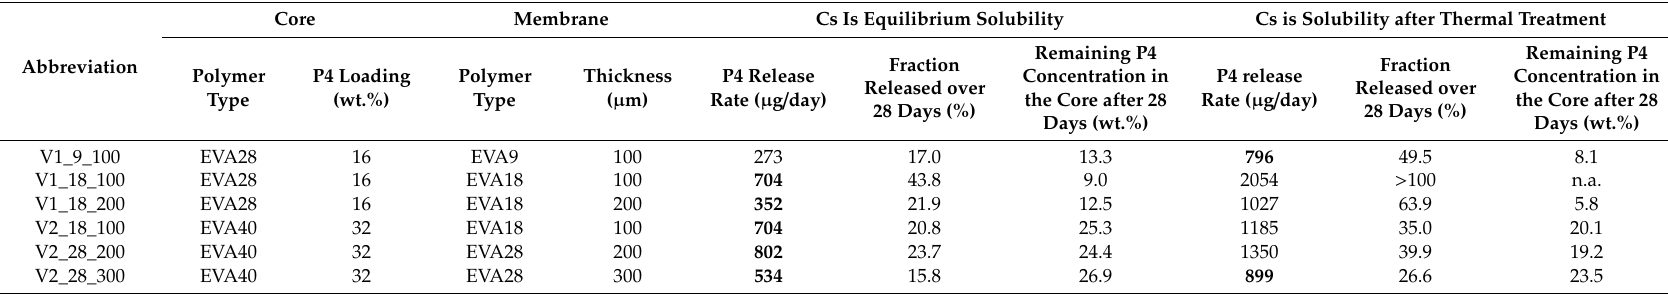
Table 1. Vacuum compression molding formulations (VCM systems) expected to approach the target progesterone (P4) release rates. All values are calculated based on the results of the pre-studies and Equation (2). Release rates approaching the target of 400–800 µ g / day are highlighted in